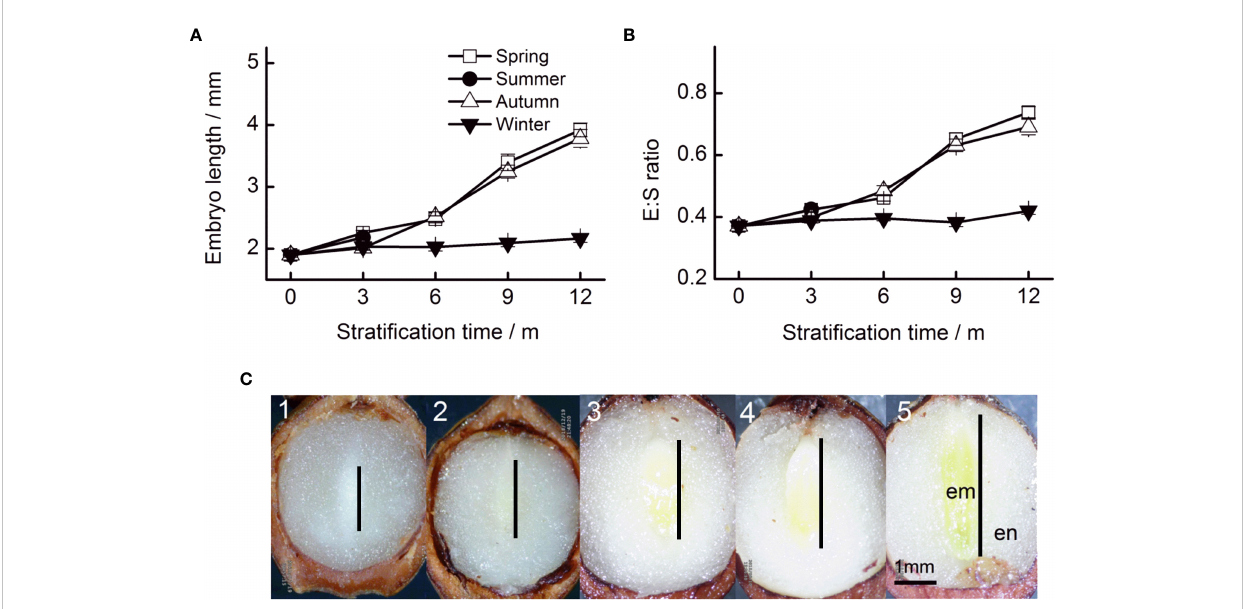
FIGURE 2 Embryo length (A) and the E : S ratio (B) of Taxus chinensis var. mairei seeds under strati fi cation at four seasonal temperature regimes. (C) Embryo growth at spring temperature regimes (1, before strati fi cation; 2, after 3 months; 3, after 6 months; 4, after 9 months; and 5, after 12 months). The vertical bars represent standard errors of the mean (n = 3). E : S ratio, embryo : seed